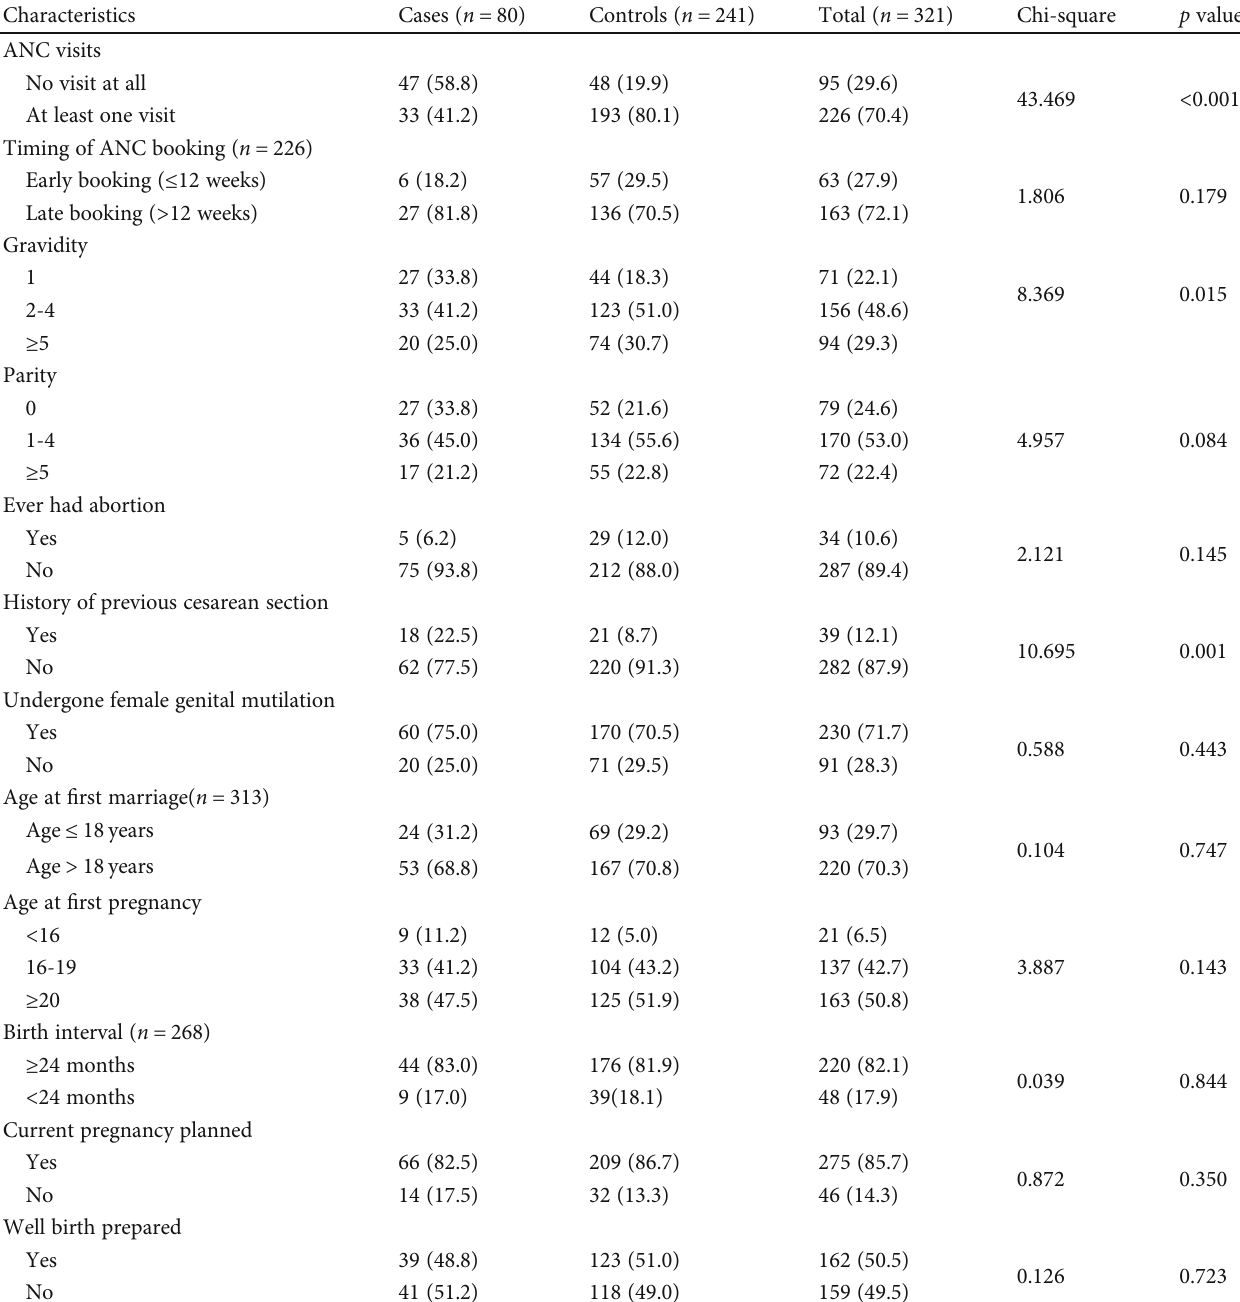
Table 2: Reproductive and obstetric characteristics of women admitted in Western Arsi zone public hospitals, Ethiopia, 2020.